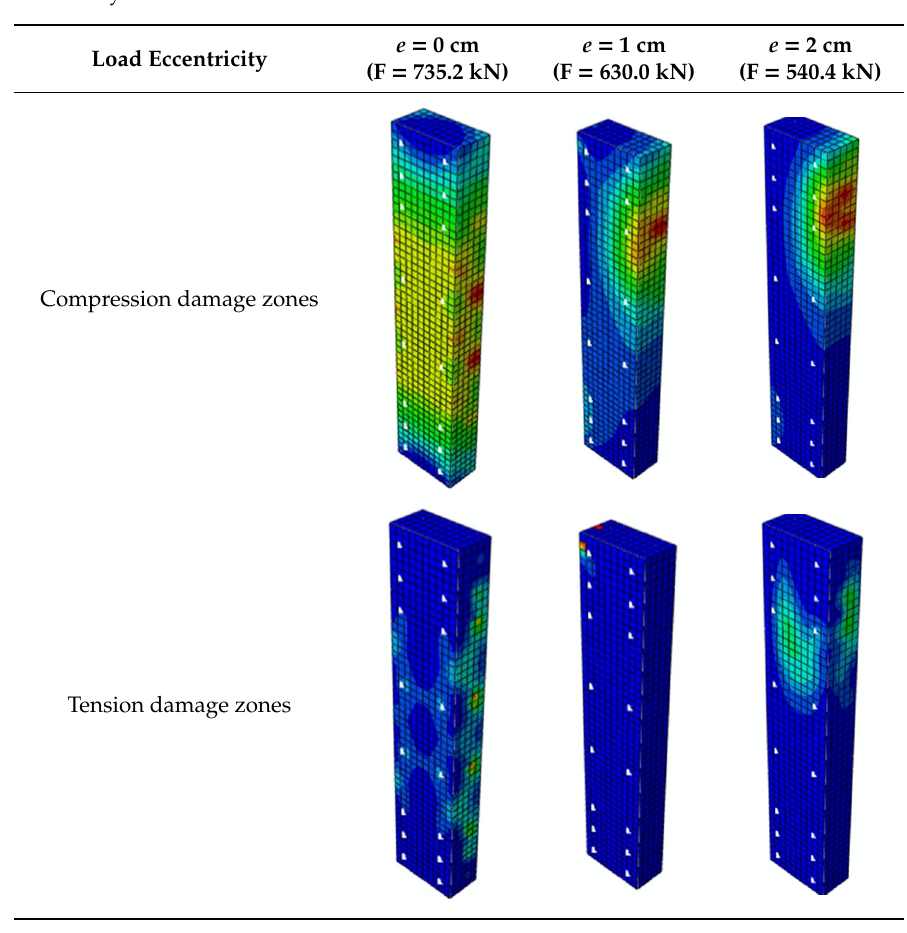
Table 6. Maps of damage zones for failure stage simulated in ABAQUS (specimen B8)—analysis of the load eccentricity influence.